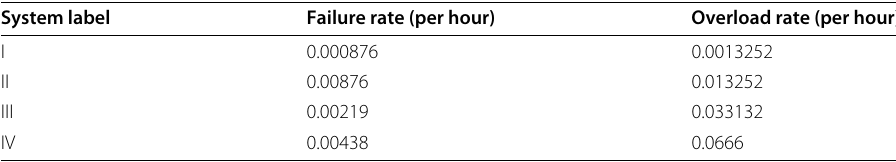
Table 2 Failure rates in ICT and branch overload rates System label